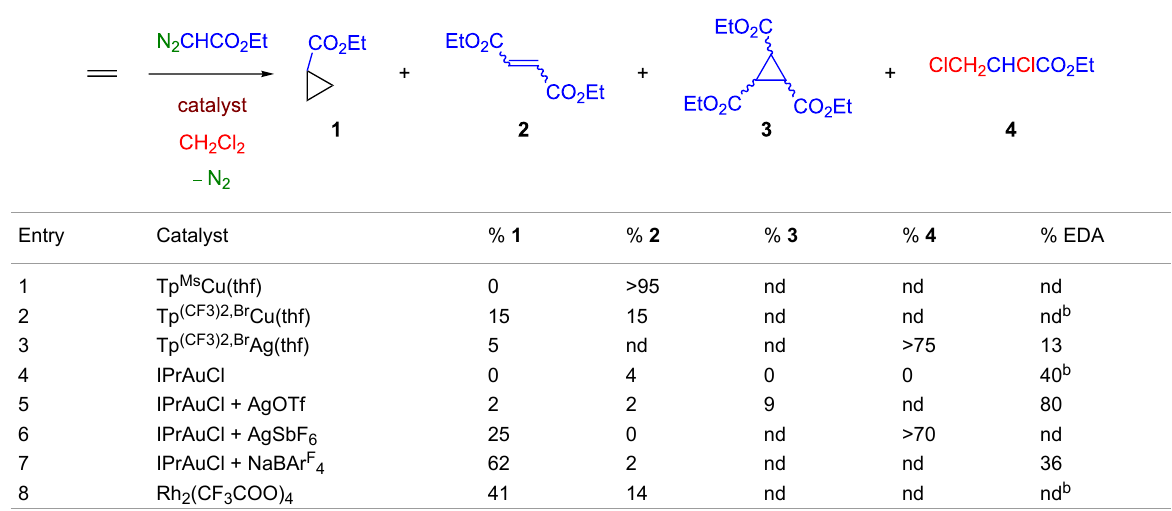
Table 1: Catalyst screening for the reaction of ethylene and ethyl diazoacetate. a